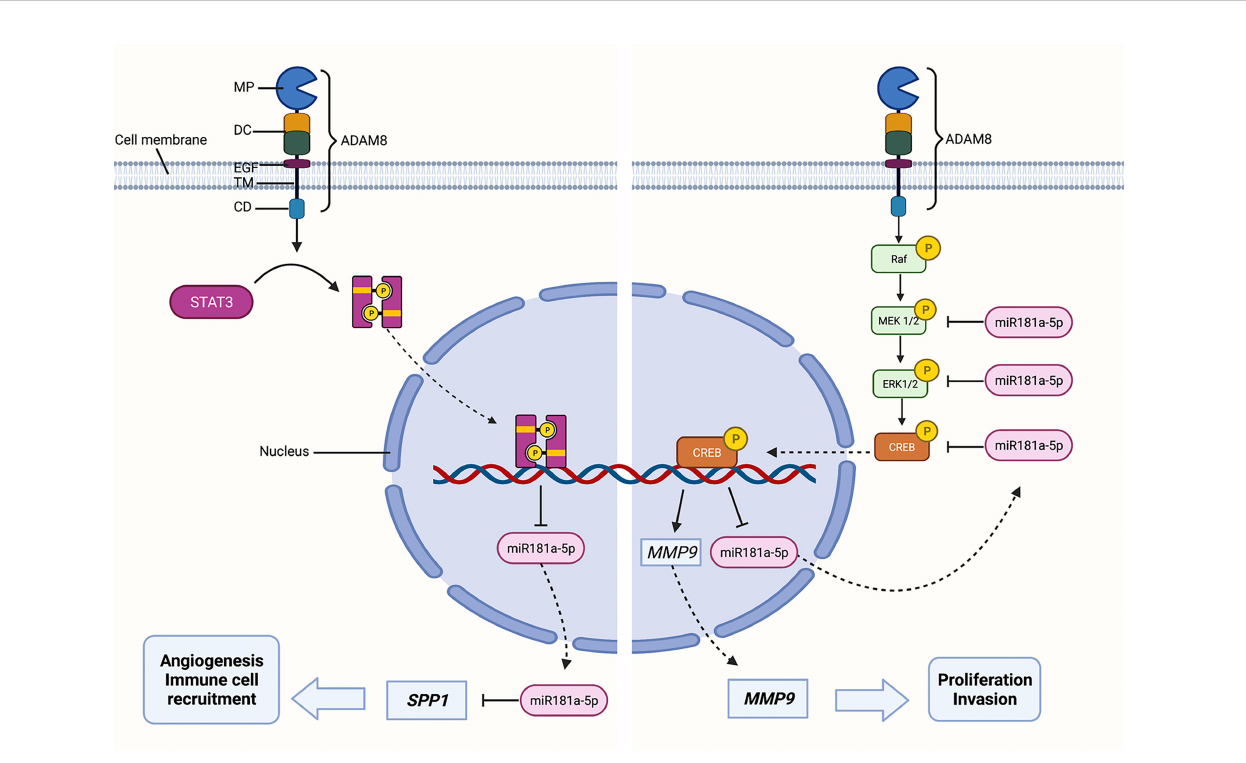
FIGURE 6 | Sketch of ADAM8-dependent effects caused by regulation of miR-181a-5p in GBM cells. ADAM8 with homologous domains including the metalloprotease domain (MP), the disintegrin/cysteine-rich domain (DC), the EGF-like domain (EGF), the transmembrane (TM), and the cytoplasmic domain (CD). ADAM8 activates intracellular signaling cascades by STAT3 and MAPK in the presence of the cytoplasmic domain. ADAM8/STAT3/miR-181a/ SPP1 axis: ADAM8 dependent STAT3 activation downregulates miR-181a-5p, as miR-181a-5p targets SPP1 , disinhibition of SPP1 leads to several tumor progressing effects such as induction of angiogenesis and enhanced immune cell recruitment. ADAM8/MAPK/MMP9 axis: ADAM8 activates the MAPK pathway, the transcription factor CREB-1 induces MMP9 transcription and inhibits miR-181a-5p transcription. MMP9 promotes tumor cell proliferation and invasion. By targeting CREB-1, ERK2, and MEK1, miR-181a-5p downregulates MMP9 expression most likely by an indirect mechanism. Created with